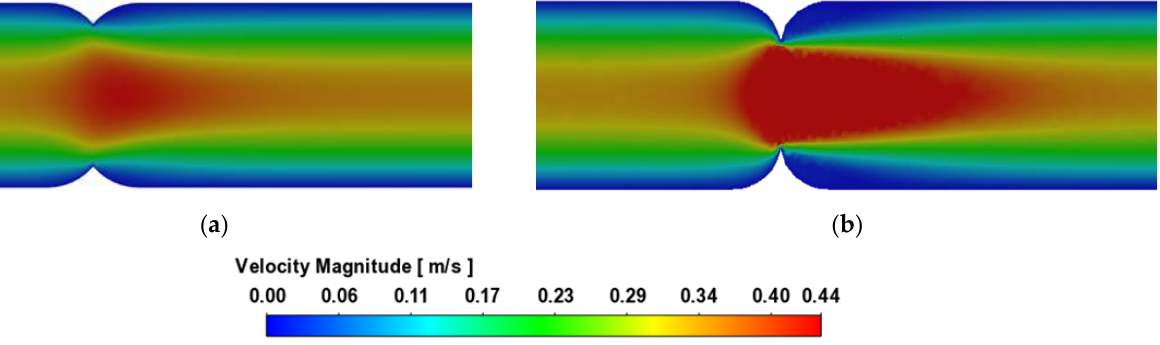
Figure 10. Velocity field in the central cross-section (m/s) for the volumetric flow rate of 0.176 m/s: ( a ) channel with a pore diameter of Ø 85 µm, ( b ) channel with a pore diameter of Ø 63 µm. The dependence of the pressure drop on the volumetric flow rate and the interpola- tion curves are shown in Figure 11. The following local hydraulic resistances have resulted from the computation: 𝜉 Ø85 = 1.29 and 𝜉 Ø63 = 16.4 .